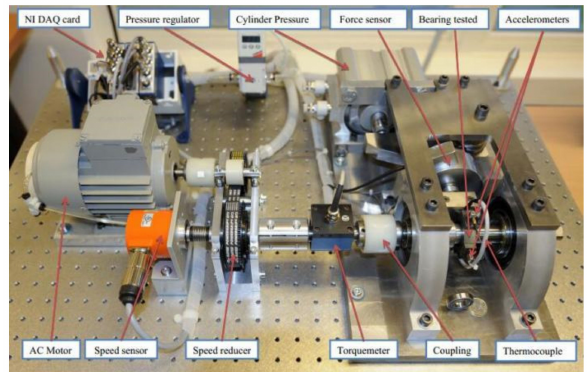
Figure 2. Overview of the experimental setup.